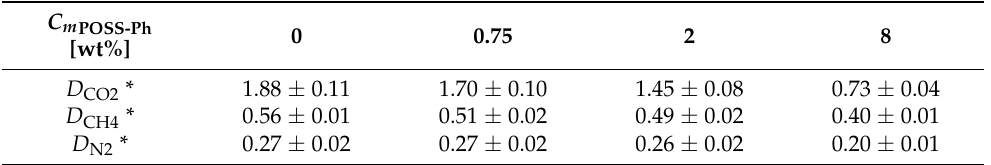
Table A11. Diffusion coefficient D i for membranes of different POSS-Ph concentrations. * The values in table should be multiplied.